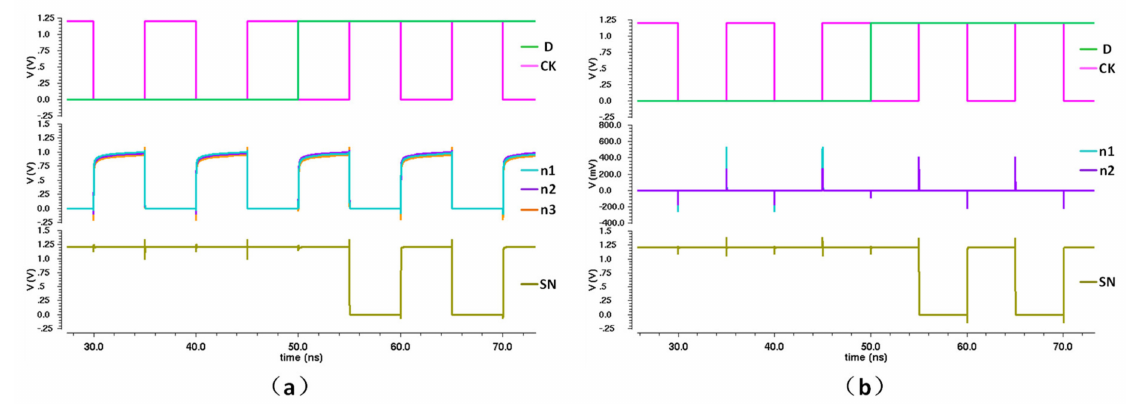
Figure 6. The voltages of the internal nodes in ( a ) the conventional SAFF’s sense-amplifier (SA) stage; ( b ) the proposed SAFF’s SA stage.